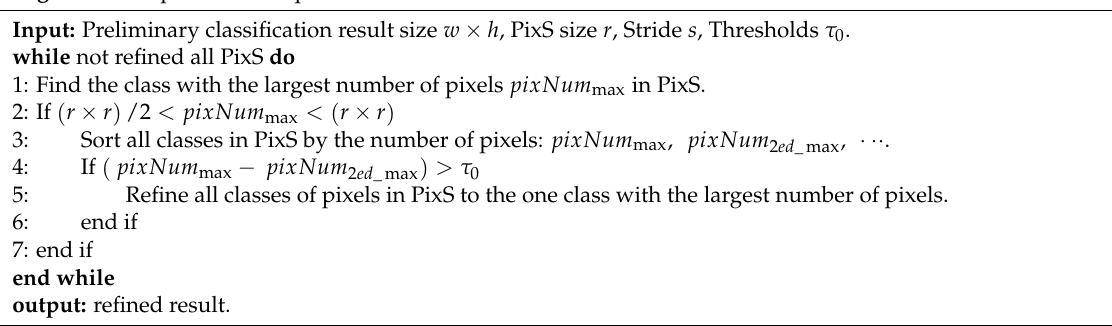
Algorithm 1: Spatial Pixel-squares